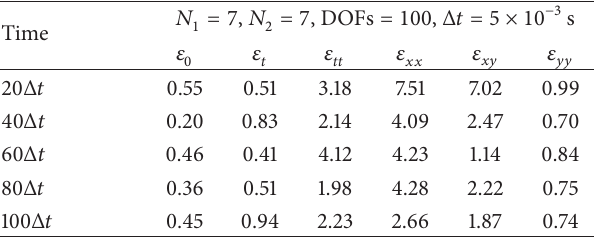
Table 5: Global errors of the manifold method. Time